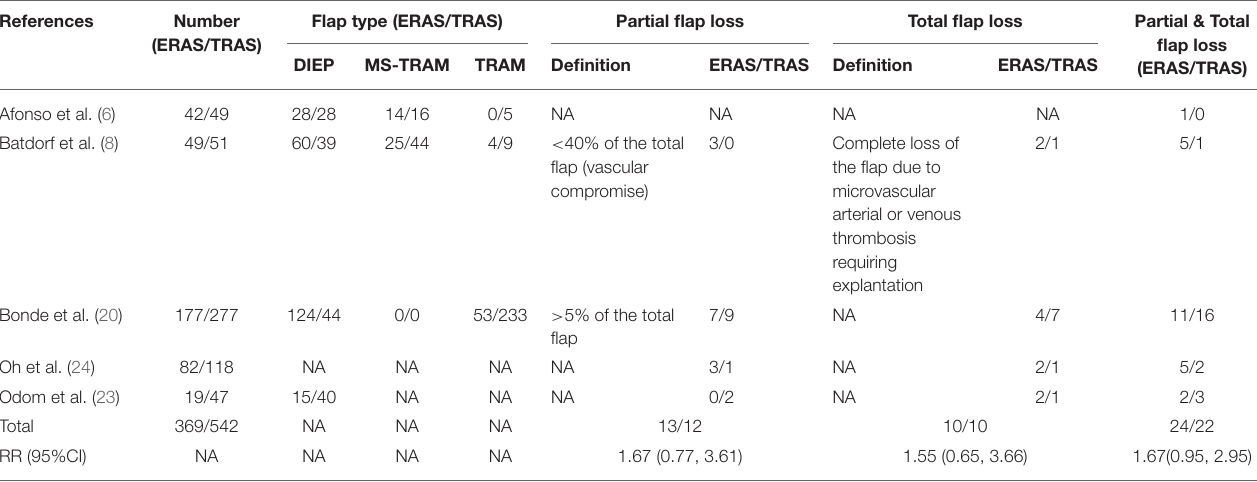
TABLE 2 | Pooled estimate of the effect of ERAS programs on incidence of partial, total, and partial & total flap loss within 30 days after autologous and implant-based breast reconstruction surgery compared to conventional perioperative care